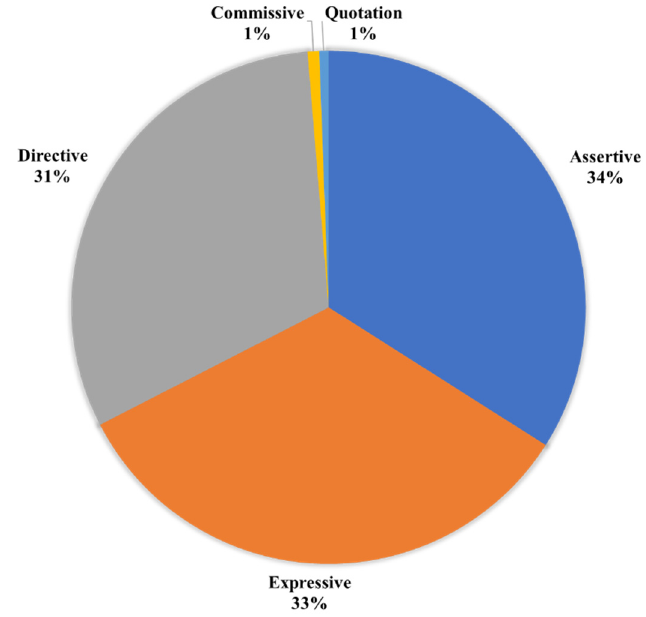
Figure 1. Frequency of speech acts in Facebook comments.